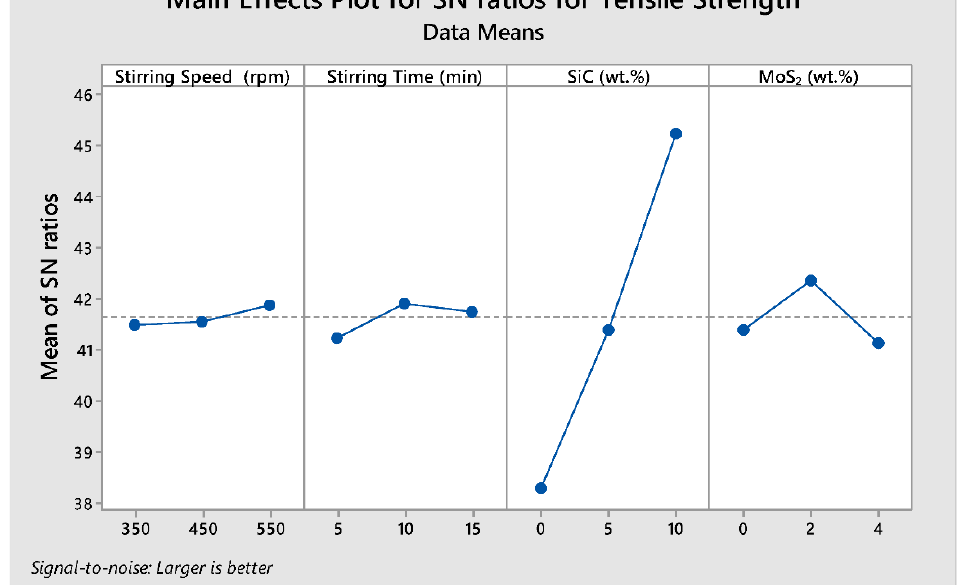
Figure 6. Main effect plots for S/N ratio of tensile strength.